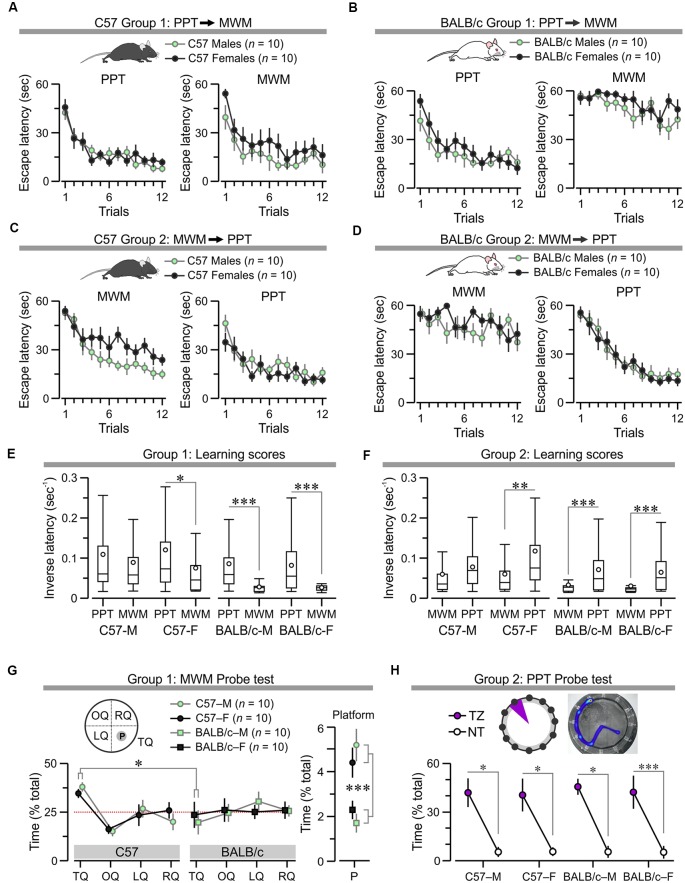
Comparison of the PPT and MWM in C57 and BALB/c mice. (A–D) Plots of escape latency (mean ± SEM) across trials, arranged by group/strain, showing that C57 mice acquire the PPT and the MWM normally and independently of testing order (A,C), while BALB/c mice acquire the PPT normally but are impaired in the MWM (B,D). (E) Boxplot of learning scores (i.e., inversed latency calculated for all trials) for subjects in Group 1 shows that only C57 males (C57-M) learn the PPT and the subsequent MWM with equal ease (T(238) = 1.35, P = 0.18, t-test), whereas the other groups show poorer acquisition of the MWM (C57 females, C57-F, T(238) = 2.79, *P = 0.004; BALB/c males, BALB/c-M, T(238) = 7.17, ***P = 9.48 × 10−12; BALB/c females, BALB/c-F, T(238) = 8.41, ***P = 3.74 × 10−15, t-test). (F) Boxplot of learning scores for subjects in Group 2 shows that C57 males learn the MWM and the PPT equally (C57-M, T(238) = 2.34, P = 0.02, t-test), whereas the other cohorts learn the MWM more poorly than the PPT (C57-F, T(238) = 3.93, **P = 0.0001; BALB/c-M, T(238) = 5.72, ***P = 3.26 × 10−8; BALB/c-F, T(238) = 6.53, ***P = 4.1 × 10−10, t-test). (G) Subjects in Group 1 were subjected to a probe test following the MWM. The left plot shows preferential search of the target quadrant for C57 mice but not BALB/c mice (T(38) = 3.13, *P = 0.003, t-test). The right plot shows that C57 mice spend significantly more time in the platform location than BALB/c mice (T(38) = 4.89, P = 1.89 × 10−5, t-test). (H) Subjects in Group 2 experienced a probe test in the clockmaze. Top, representative heatmap of a subject who had been trained to escape through exit 11. Abbreviations: TZ, target zone; NT, non-target zones. Bottom, plot showing preferential search of the TZ in all groups (C57-M, T(18) = 4.12, *P = 6.5 × 10−4; C57-F, T(18) = 3.43, *P = 0.002; BALB/c-M, T(18) = 3.97, *P = 8.97 × 10−4; BALB/c-F, T(18) = 7.2, ***P = 1.06 × 10−6, t-test).